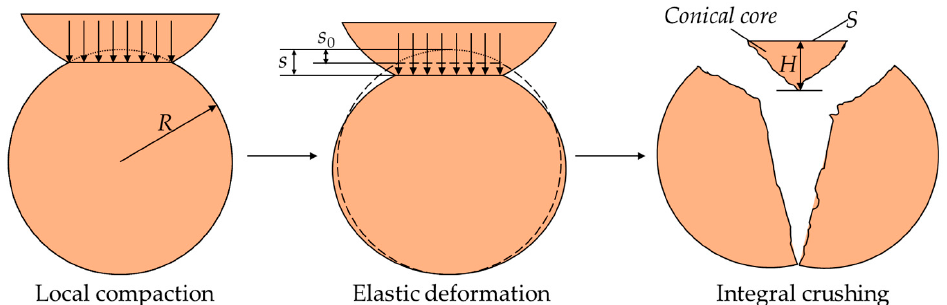
Figure 1. A sketch of the contact breakage process of spherical particles under ball–ball normal contact conditions. The s 0 is the critical displacement of the contact point center between the stages of local compaction and elastic deformation. S and H are the bottom area and height of the conical core, respectively.